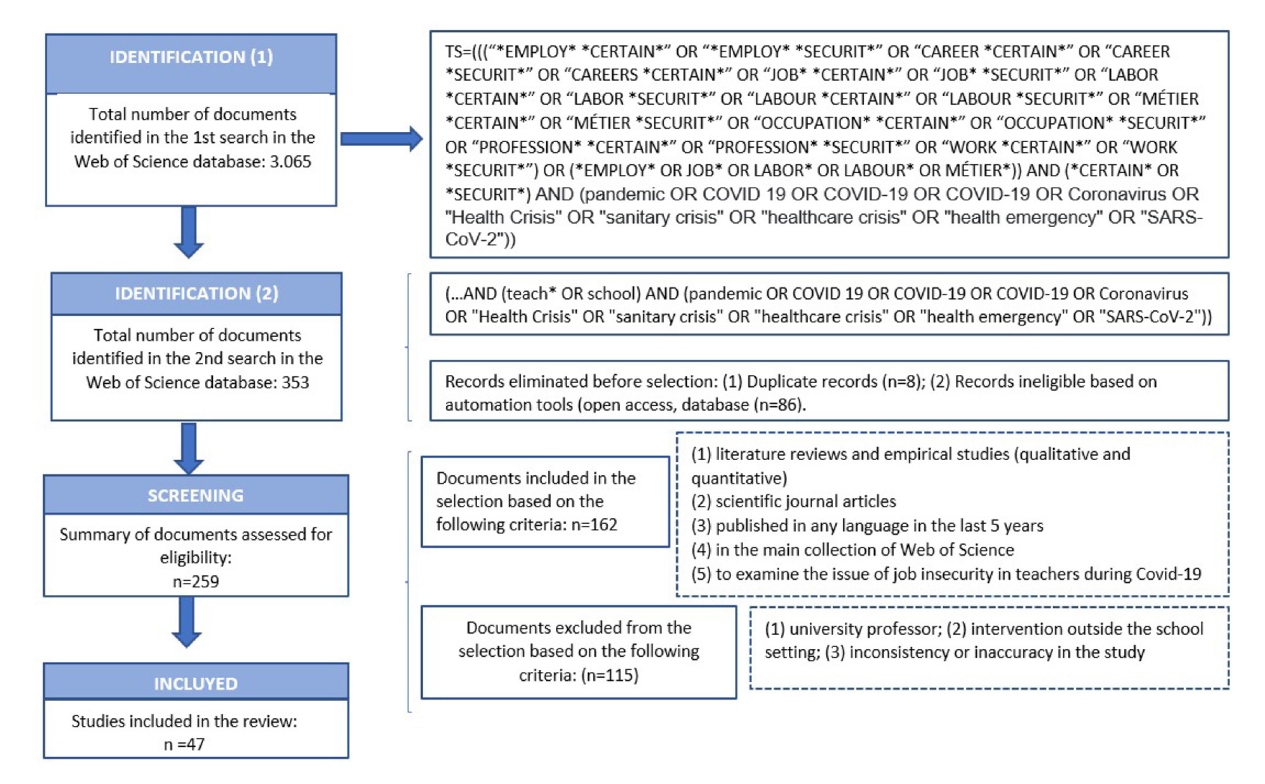
FIGURE1 PRISMA flowchart showing the steps in source identification and selection. Adapted from Thananusak (53) and Page et al.